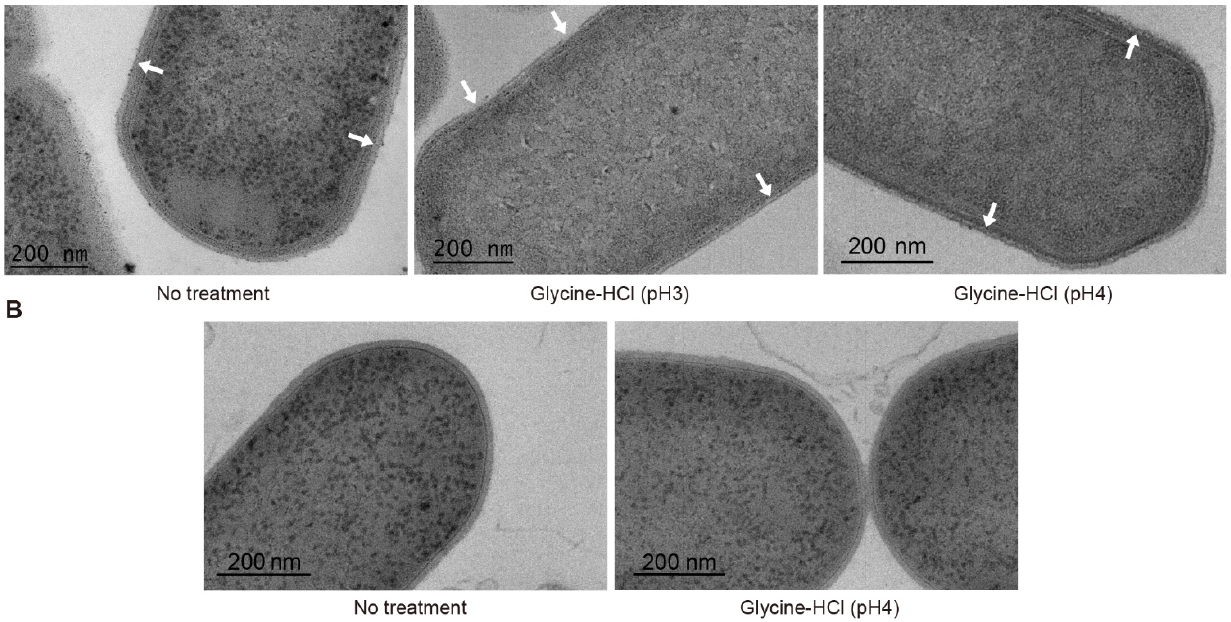
Figure 2. Representative TEM images of vegetative cells of Clostridium botulinum ATCC3502 ( A ) and ATCC19397 ( B ). The cells were treated or not treated with 0.2 M glycine-HCl (pH 3 or 4) for 1 min. White arrows indicate intact the S-layer (no treatment), broken and detached S-layer (glycine-HCl, pH 3), and granulated S-layer (glycine-HCl, pH 4).